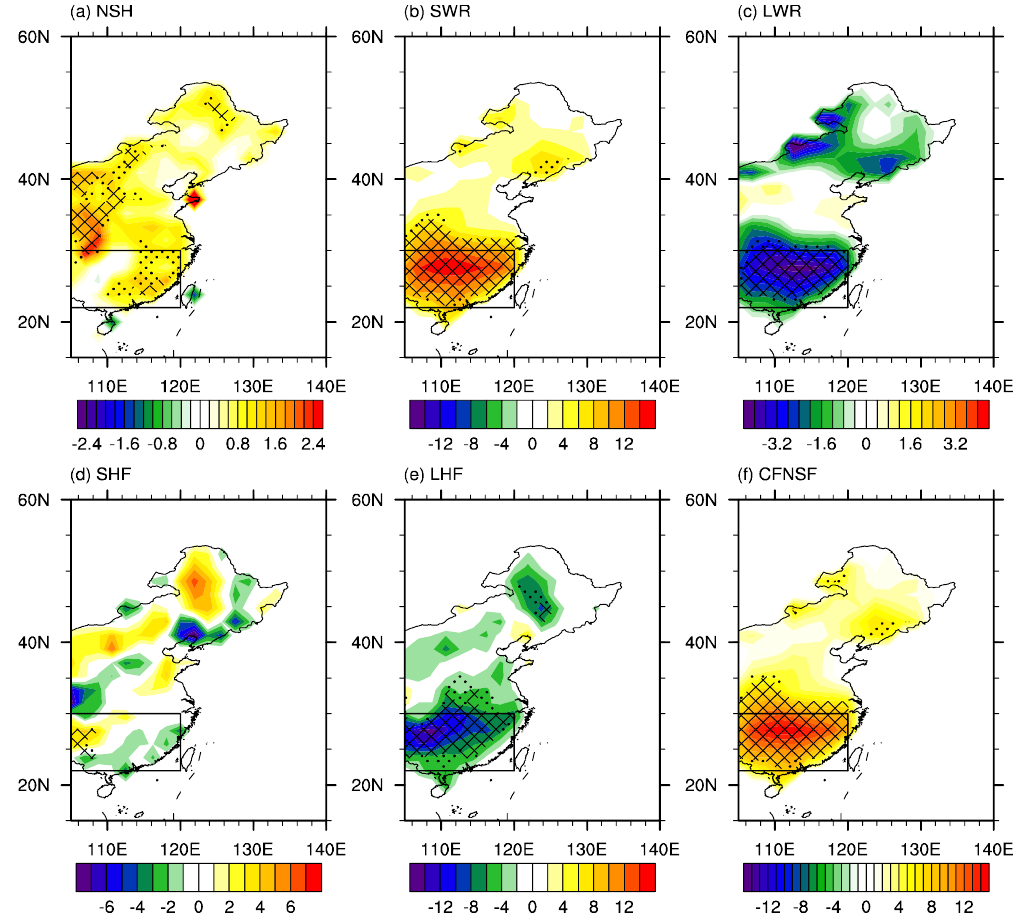
Figure 5. The differences in the summer mean ( a ) net surface flux (NSH), ( b ) surface net shortwave radiation (SWR), ( c ) surface net longwave radiation (LWR), ( d ) surface sensible heat net flux (SHF), ( e ) surface latent heat net flux (LHF), and ( f ) cloud forcing net solar flux (CFNSF) between P2 and P1 (P2 minus P1, unit: W m − 2 ). The positive direction is defined as downward. Dots and meshes in ( a – f ) denote where the anomalies are significant at the 90% and 95% confidence levels based on Student's t- test, respectively. The black rectangle in ( a – f ) refers to the domain of southern China.